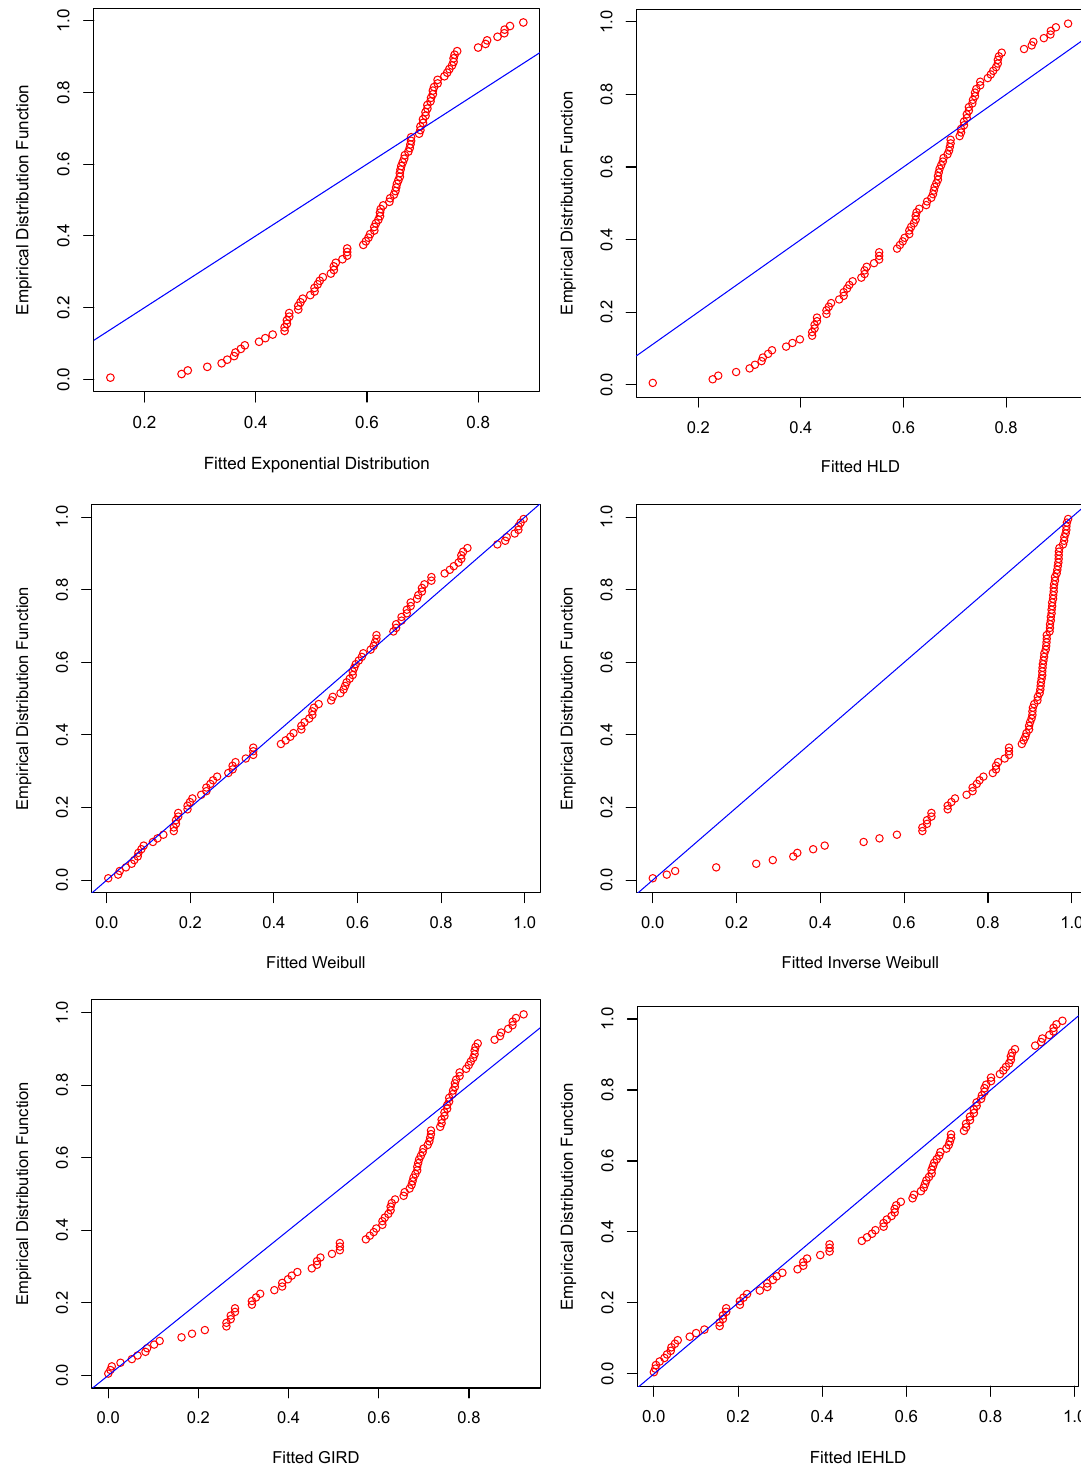
Figure 2. Q-Q plots of fitting different models to the practical